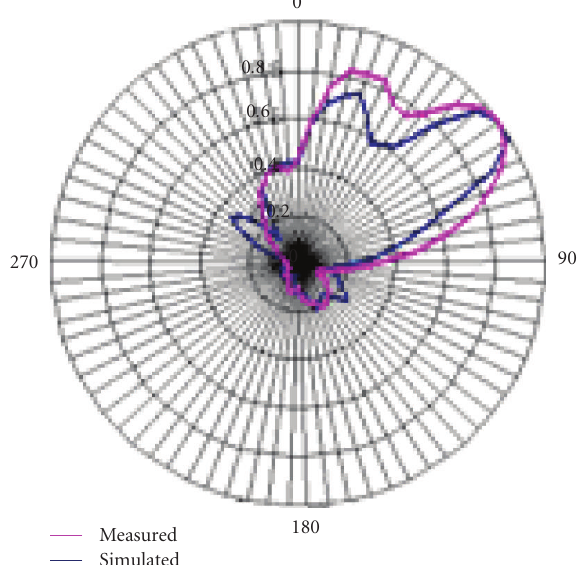
Figure 15: FDTD dispersion characteristics of LWA Type III first high mode with relative dielectric constant 1.1 and width 12